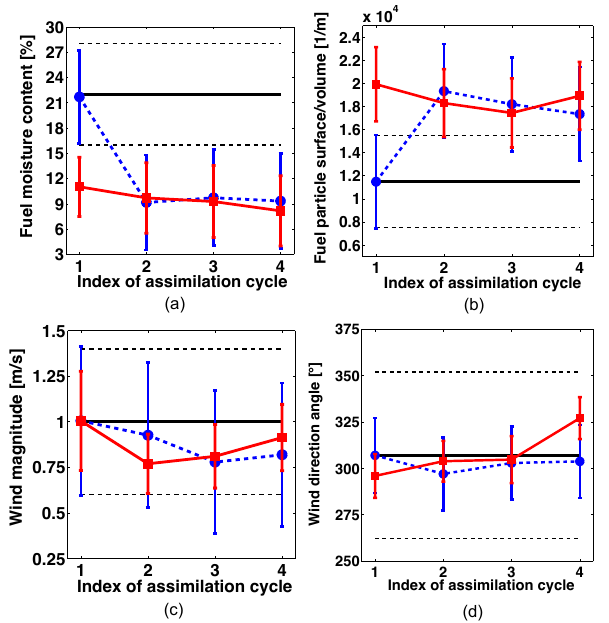
Figure 17. Evolution of ROS model parameters at four successive analysis times; controlled grassland fire experiment. PE-based en- semble: blue circle symbols (connected by a dashed line) indicate mean values in the forecast ensemble; red square symbols (con- nected by a solid line) indicate mean values in the analysis en- semble; vertical bars indicate the corresponding STD. SE-based ensemble: black horizontal solid lines indicate mean values; black horizontal dashed lines indicate STD. (a) Biomass fuel moisture content M v (%). (b) Biomass fuel particle surface-to-volume ra- tio (cid:54) v (m − 1 ). (c) Wind magnitude u ∗ w (ms − 1 ). (d) Wind direction α ∗ w ( ◦